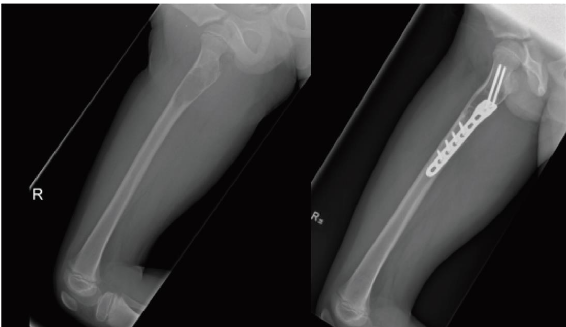
Figure 2: Postoperative images (medial and lateral) of a patient who received open reduction and internal fxation with bone substitute